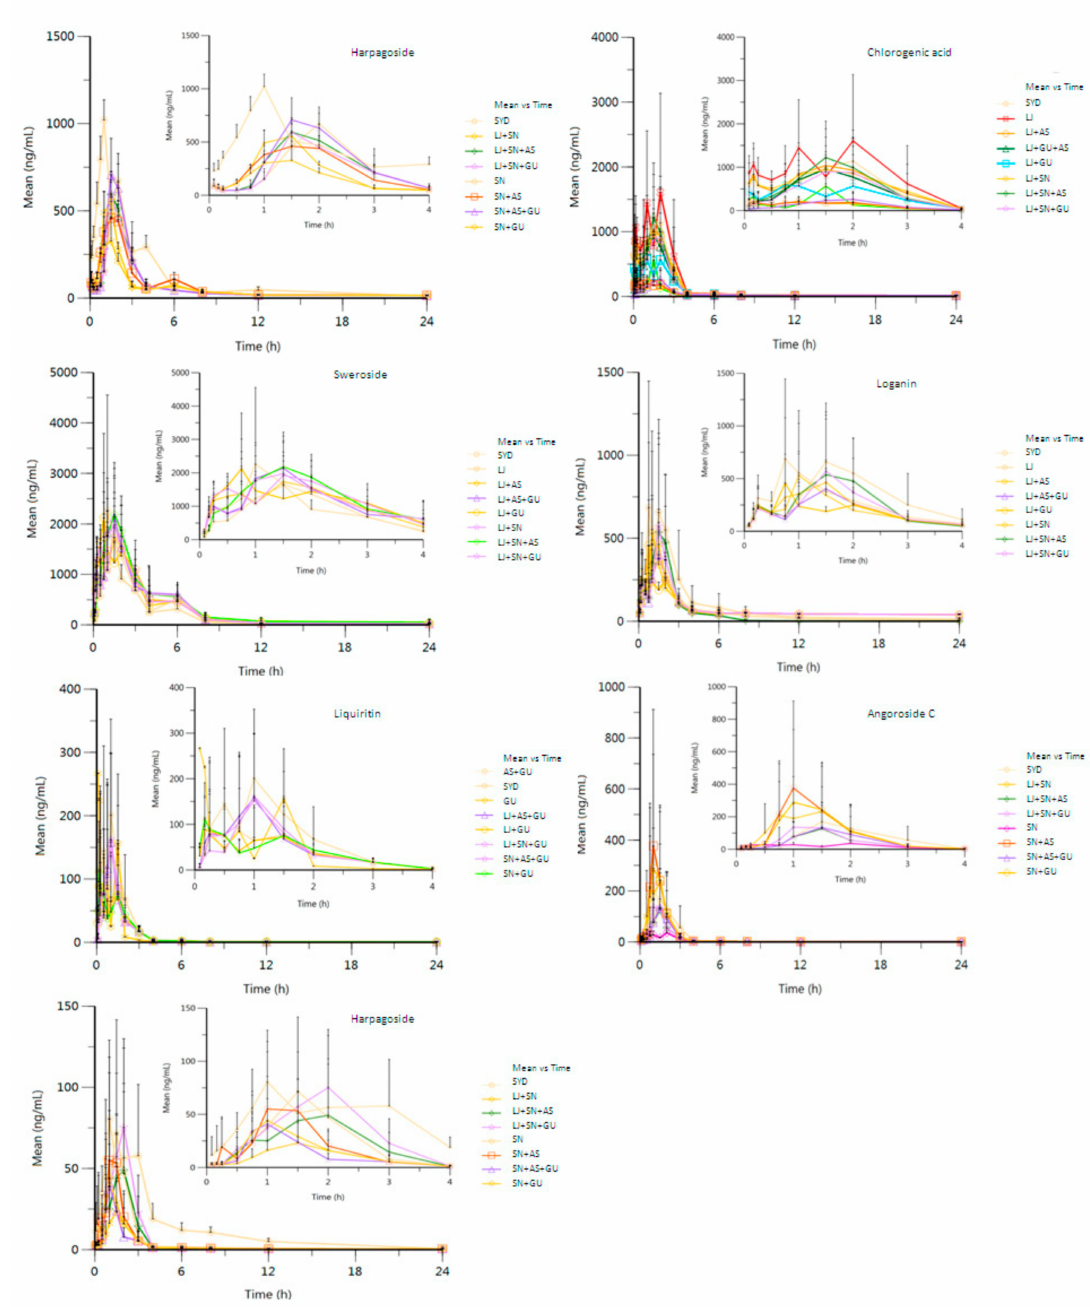
Figure 2. Plasma concentration-time curve of the seven compounds in the fifteen groups of compatibility combinations (mean ± SD, n = 6